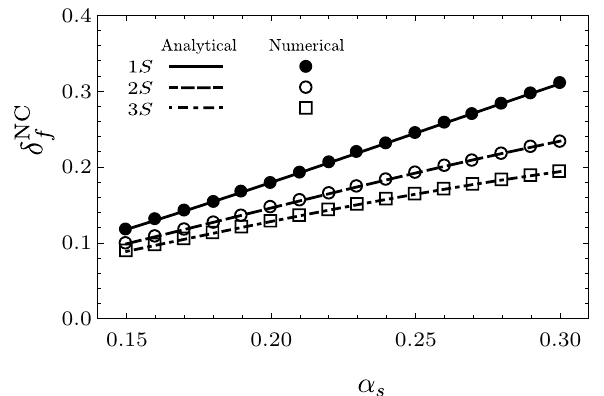
Figure 9 . Comparison of numerical calculations and analytical results for the non-Coulombic corrections δ NC